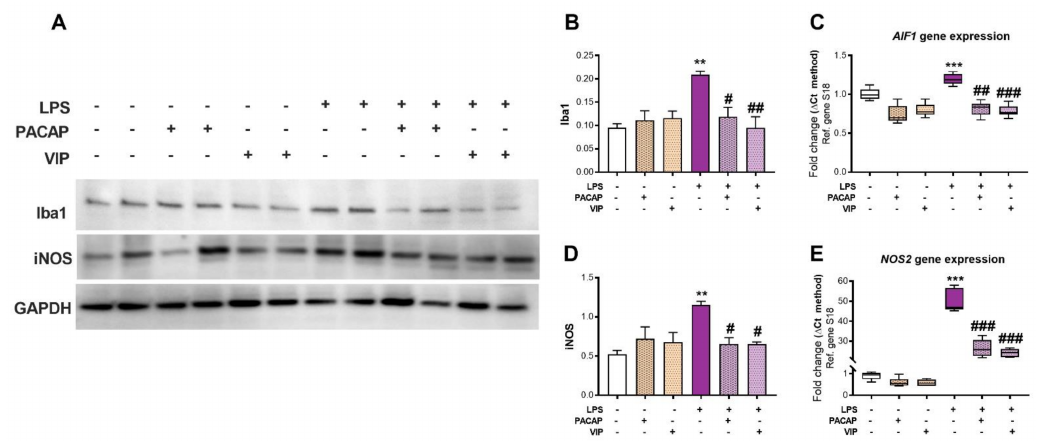
Figure 4. Effects of treatment with PACAP or VIP on LPS-induced microglia activation markers in BV2 cells. Real-time qPCR and Western blot analyses depicting AIF1 /Iba1 and NOS2 /iNOS mRNA and protein expression levels in cells exposed to LPS (1 µ g/mL) and after co-treatment with either PACAP or VIP at 24 h. mRNA levels of AIF1 ( C ) and NOS2 ( E ) and related proteins (Iba1 and iNOS ( A , B , D )) are shown. qPCR data represents means of n = 5–6 biological replicates for each group. Results are expressed as mean ± SEM. ** p < 0.01 or *** p < 0.001 vs. control; # p < 0.05, ## p < 0.01 or ### p < 0.001 vs. LPS only, as determined by one-way ANOVA followed by the Tukey post hoc test. Western blot data represent the mean of four independent experiments, each run in duplicate. AIF1 : Ionized calcium binding adaptor molecule 1 (Iba1), GAPDH: Glyceraldehyde3-phosphate deyhydrogenase, S18: ribosomal protein subunit.